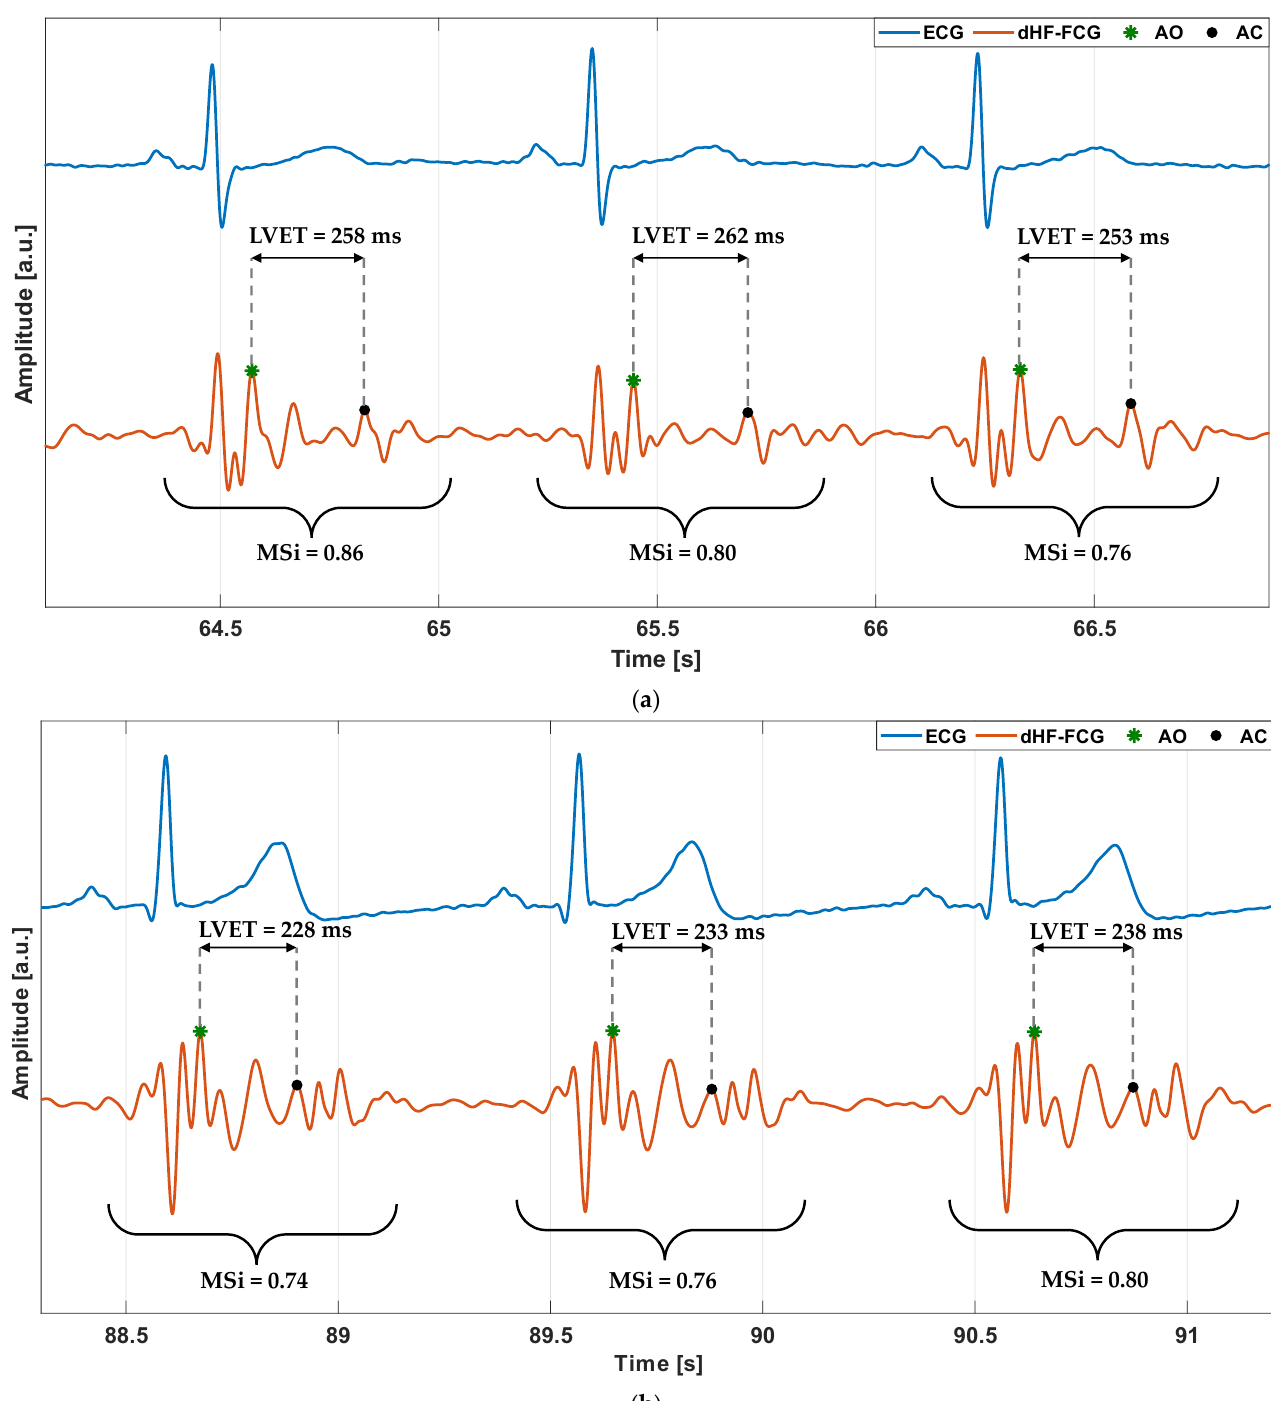
Figure 3. Example of LVET and MSi estimations of dHF-FCG signals (orange lines) from: ( a ) subject #2; ( b ) subject #4. ECG signals (blue lines) are also reported as a time reference for the cardiac cycle.